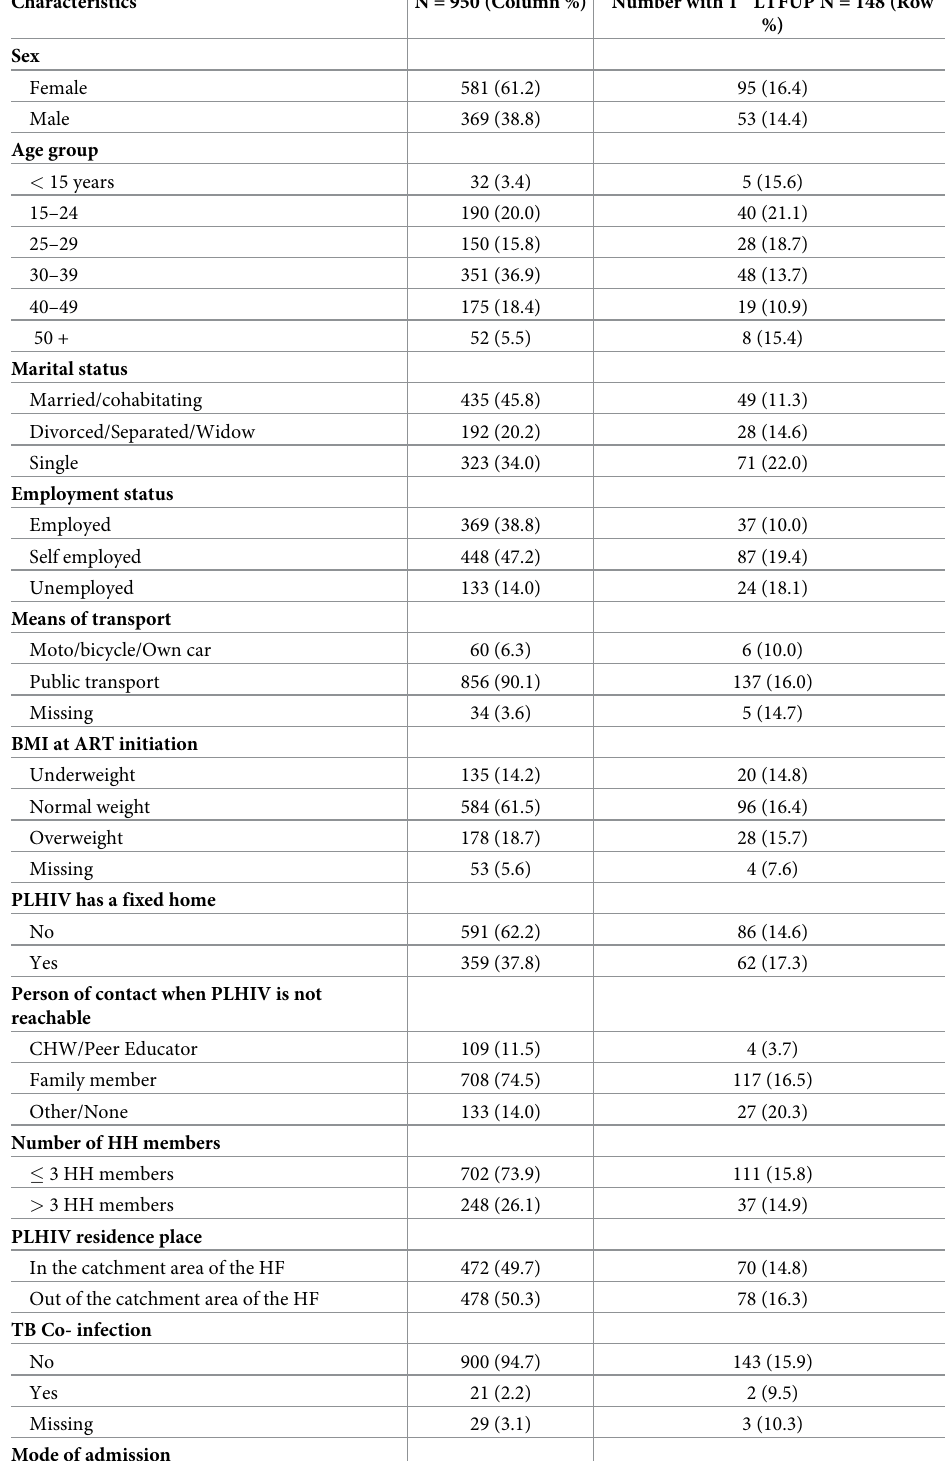
Table 1. Distribution of sociodemographic and clinical characteristics of PLHIV and Lost to follow up among PLHIV who initiated ART in 2018, Nyarugenge district, Rwanda.